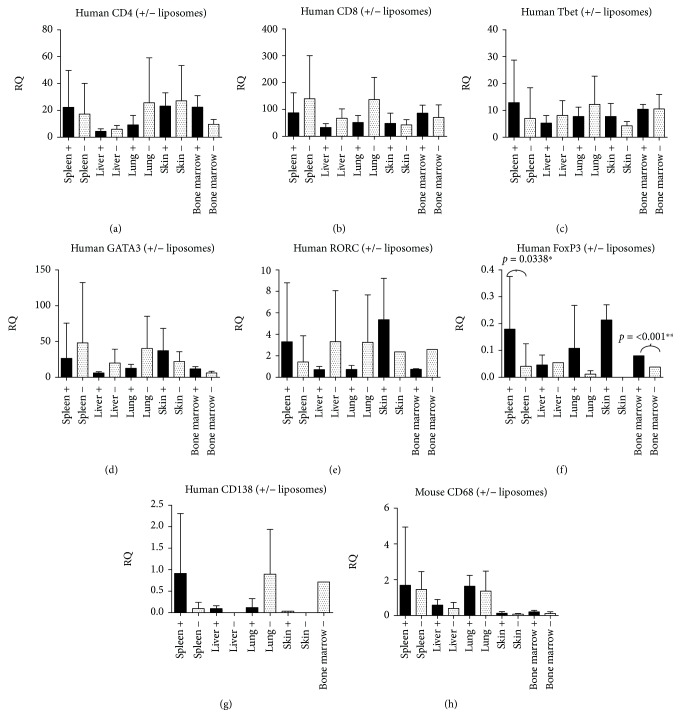
Expression of mRNA for specific cell marker mRNA in macrophage depletion. RQ values are shown from macrophage-depletion experiment 2; RAG2 −/−γc−/− mice injected with huPBMCs with macrophage depletion due to clodronate-containing liposomes (indicated as +) and RAG2 −/−γc−/− mice injected with huPBMCs without this depletion (indicated as -), for different human cell types, including FoxP3 (Tregs), GATA3 (Th2 cells), Tbet (Th1 cells), RORC (Th17 cells), CD4 (T helper cells), CD8 (cytotoxic T-cells), and CD138 (plasma cells) as well as for murine CD68 (murine macrophages). Human CD68 showed cycle threshold values above 30 only and human macrophages were therefore considered as virtually not present.